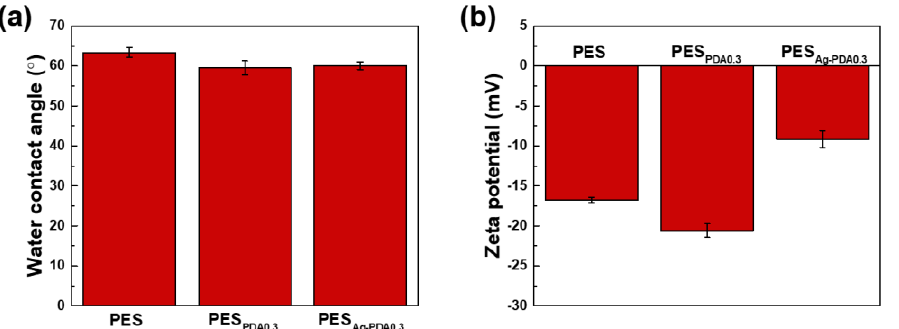
Figure 6. ( a ) Water contact angle and ( b ) zeta potential of the membranes. The water contact angle was measured after 1 min contact of the droplet on the membrane surface. Zeta potential was measured at pH =